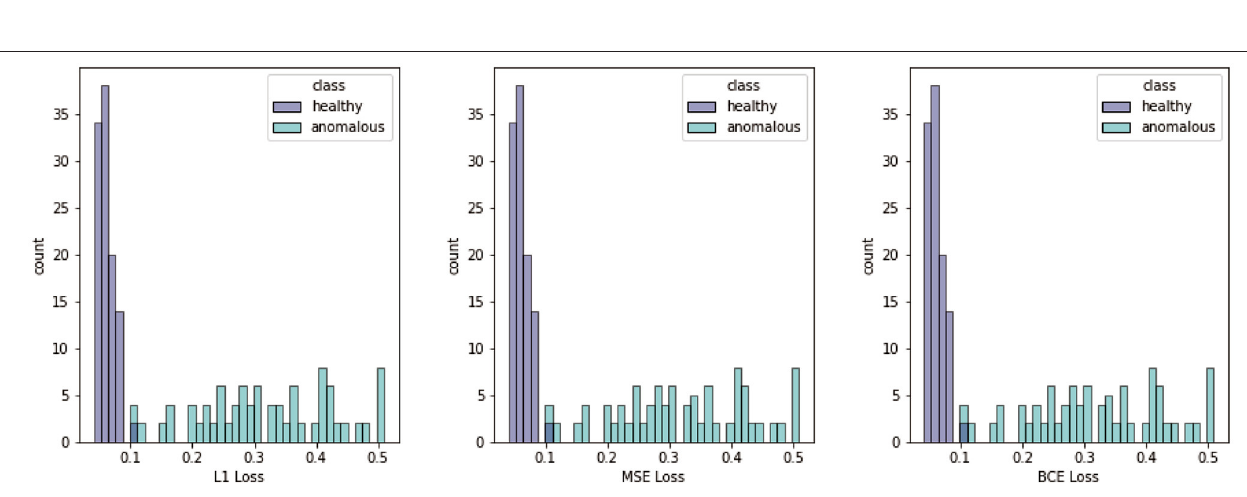
Frontiers in Plant Science | www.frontiersin.org